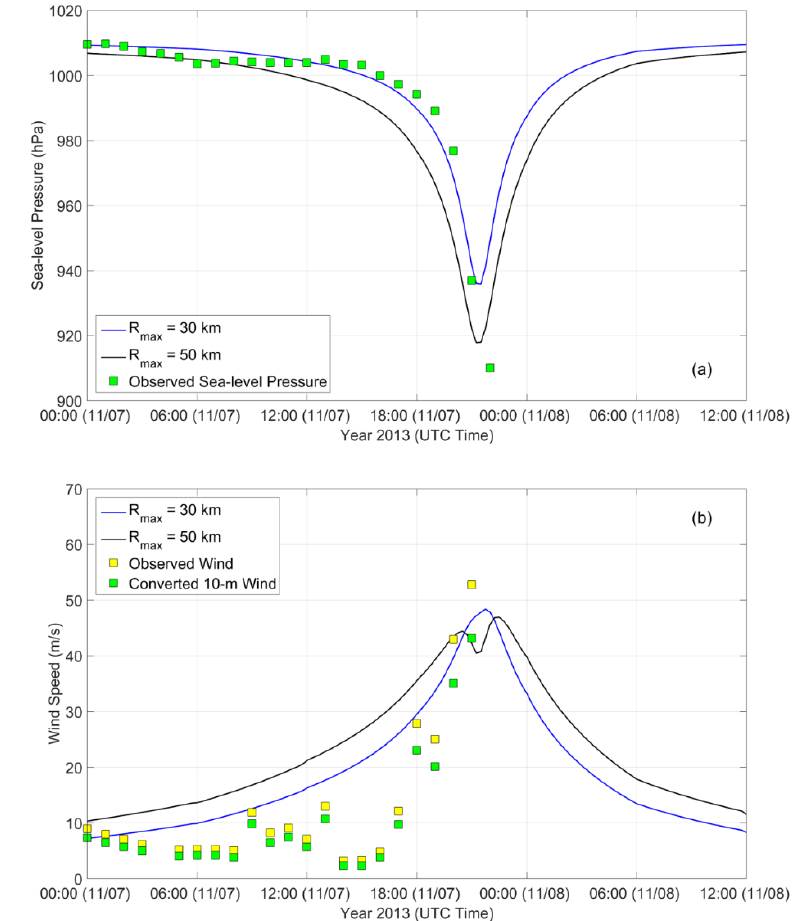
Figure 4. Comparisons of HWM results between R max = 30 and 50 km with the observation data at the Guiuan weather station: ( a ) sea-level pressure; ( b ) wind speed. The 1954 Schloemer’s pressure distribution is assumed. Note that the wind speed is measured on the level of 60 m [18], and the 10-m wind speed is converted using the power-law formula [67].